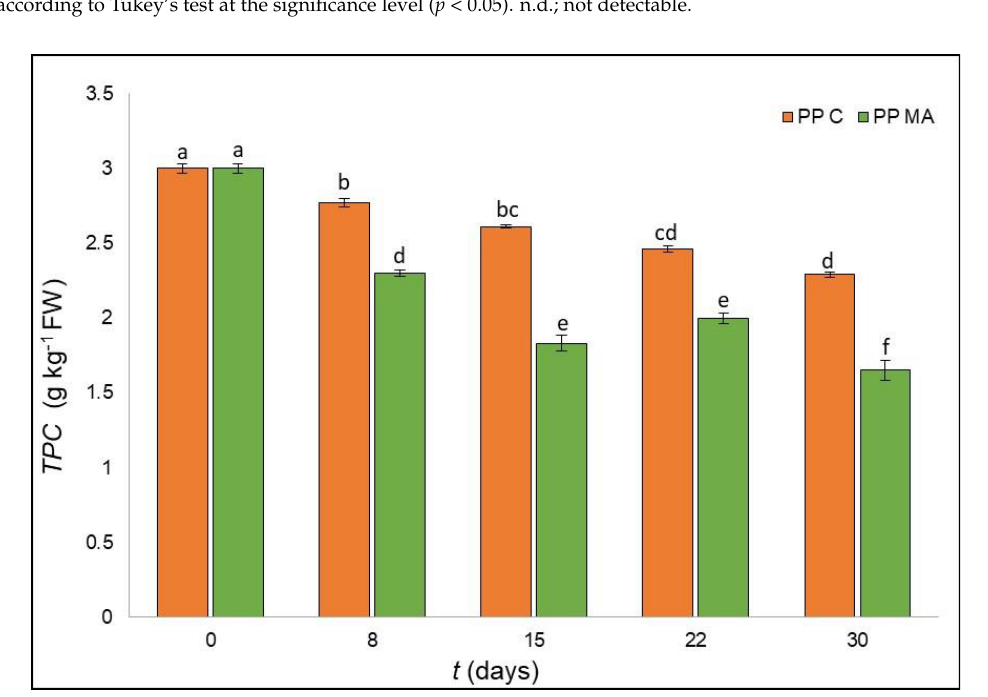
Figure 1. Total phenolic content of green asparagus in PP C and PP MA during 30 days of storage. Data represent the mean of three replicates ± standard deviation. Means with different letters are significantly different ( p < 0.05) according to Tukey’s